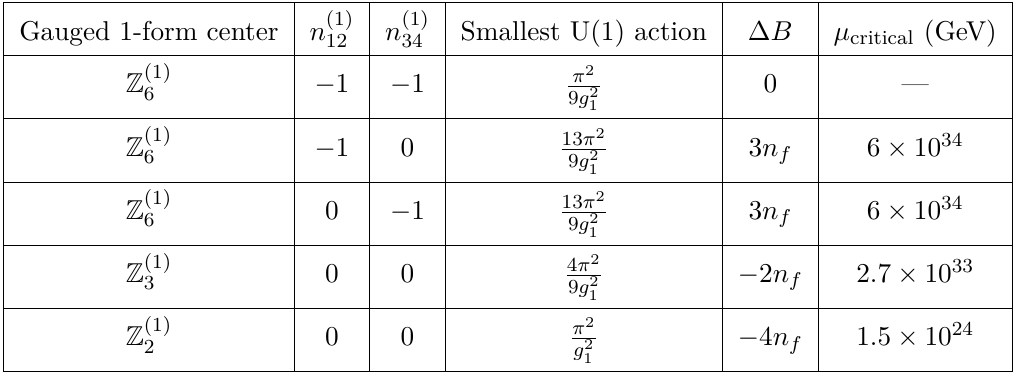
Table 1 . The smallest U(1) action S of fractional instantons, obtained by varying the integer- (1) valued U(1) fluxes n (1) µν , for the different choices of the Standard Model gauge group G N two rightmost columns, we show the corresponding value of ∆ B for n f fermion generations and the scale µ critical (taking n f = 3 ) above which the fractional instantons begin to dominate over the BPST